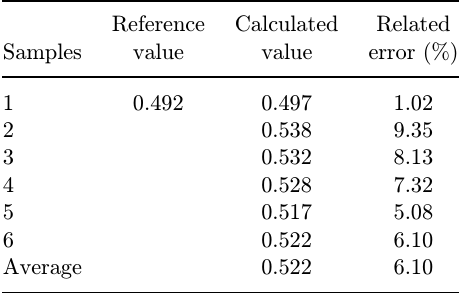
Table 3(a). The results of no sample of tablet involved in the calibration set.